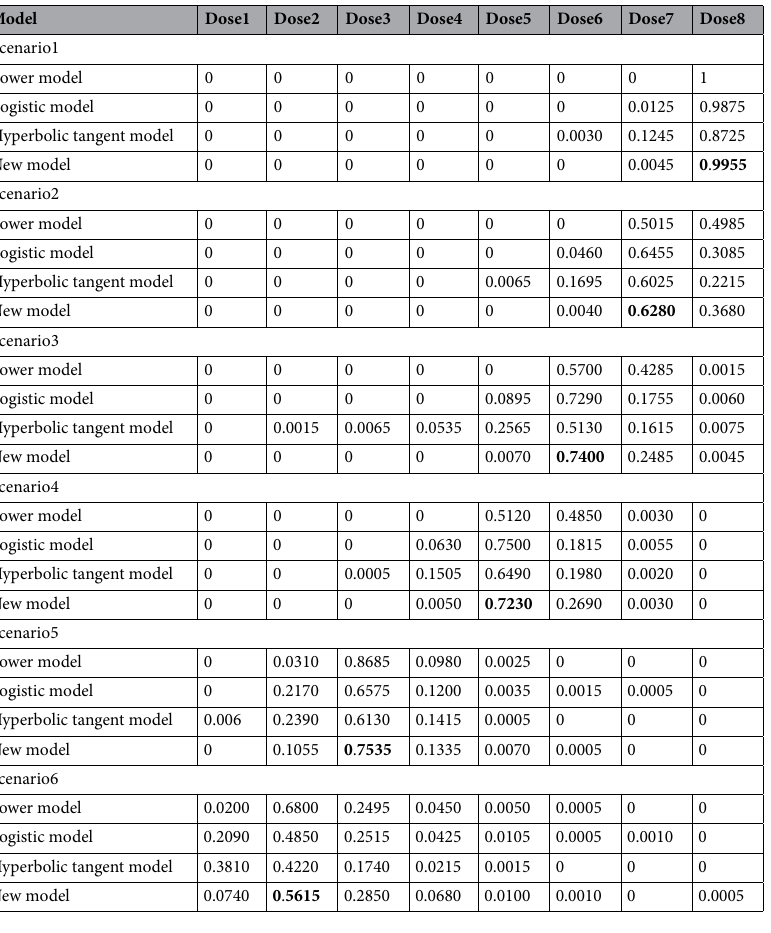
Table 2. Probability of each dose being chosen as the final MTD according to different models. Results of new model at MTDs are in